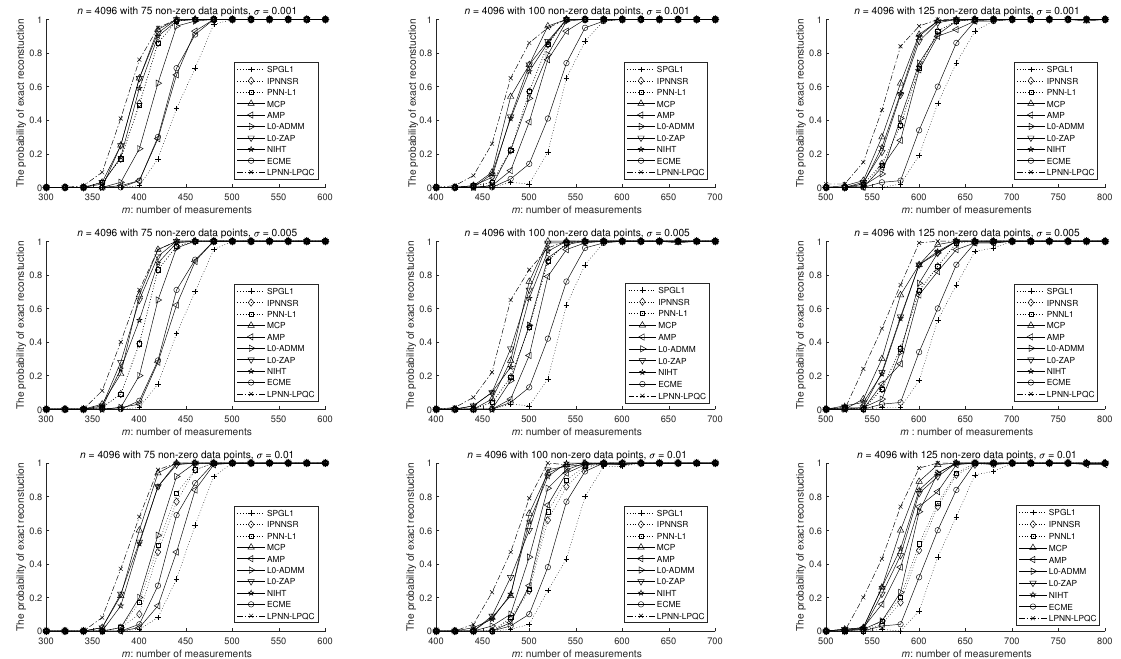
Figure 7. Simulation results of different algorithms, where n = 4096. For the first column, k = 75. For the second column, k = 100. For the third column, k = 125. The three rows are based on three different noise levels. The experiments are repeated 100 times using different